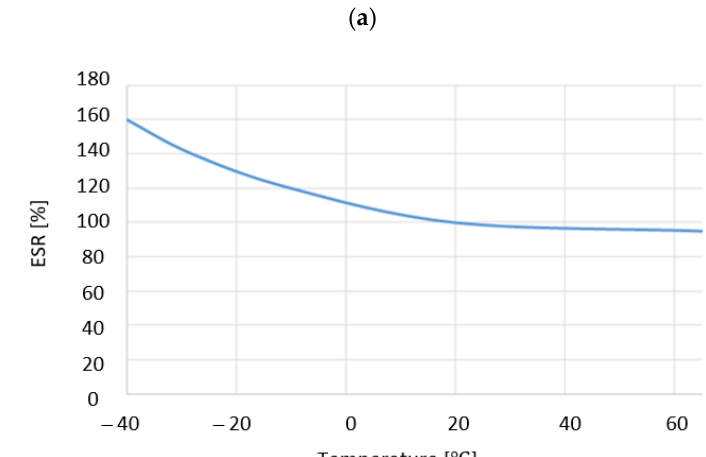
Characteristics